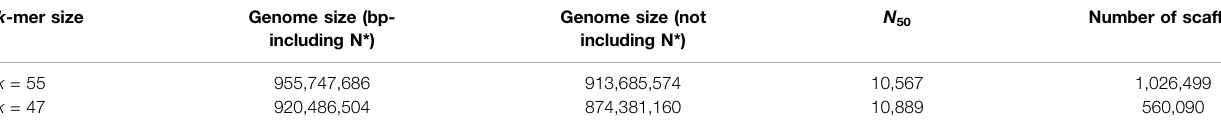
TABLE 2 | Description of the S. brasiliensis genomic assemblies performed with SOAPdenovo 2.